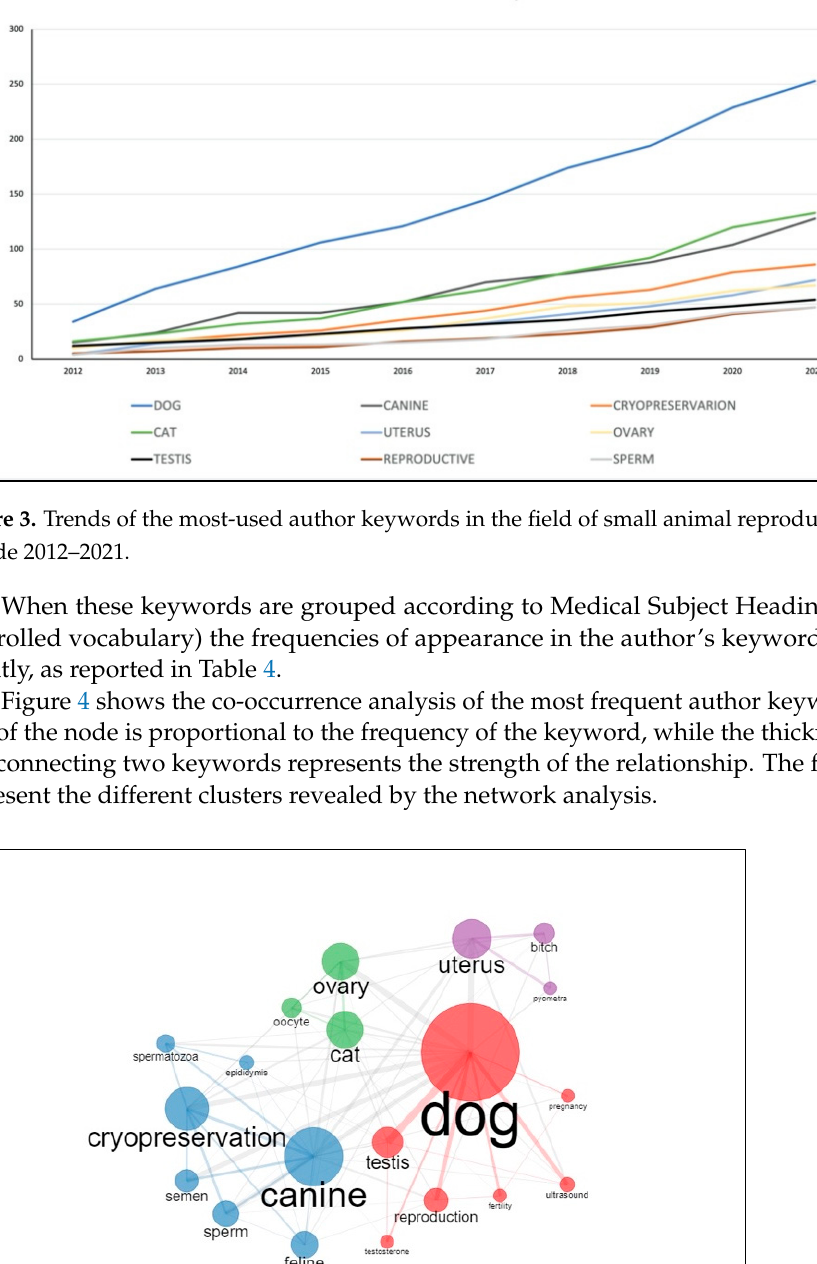
Figure 4. Co-occurrence analysis of the most frequent author keywords in the field of small animal reproduction. Keywords are grouped in four clusters and the thickness of the lines connecting keywords represents the strength of their relationship. The diameter of nodes is proportional to the frequency of each keyword.